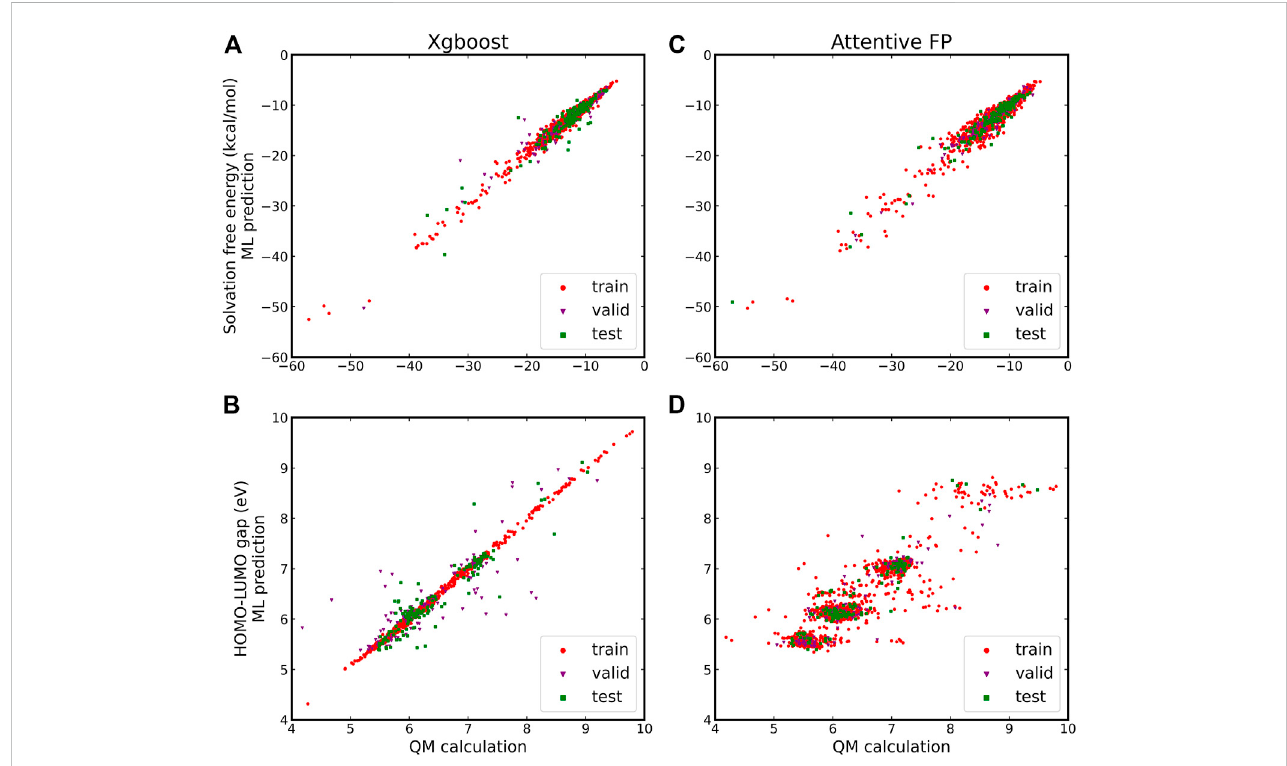
FIGURE 2 A comparison of Xgboost and Attentive FP methods to predict the solvation-free energies and HOMO-LUMO gaps of 1,517 quinone molecules. (A) Xgboost for predicting the solvation free energies; (B) Xgboost for predicting the HOMO-LUMO gaps; (C) Attentive FP for predicting the solvation free energies; and (D) Attentive FP for predicting the HOMO-LUMO gaps.